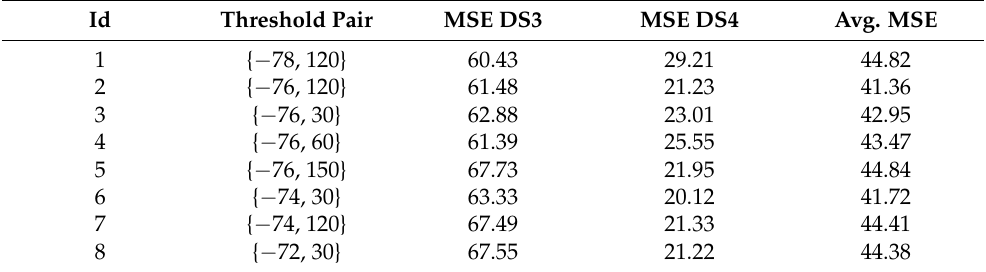
Table 3. Evaluation of threshold pairs via MSE between GT and WLAN estimator.